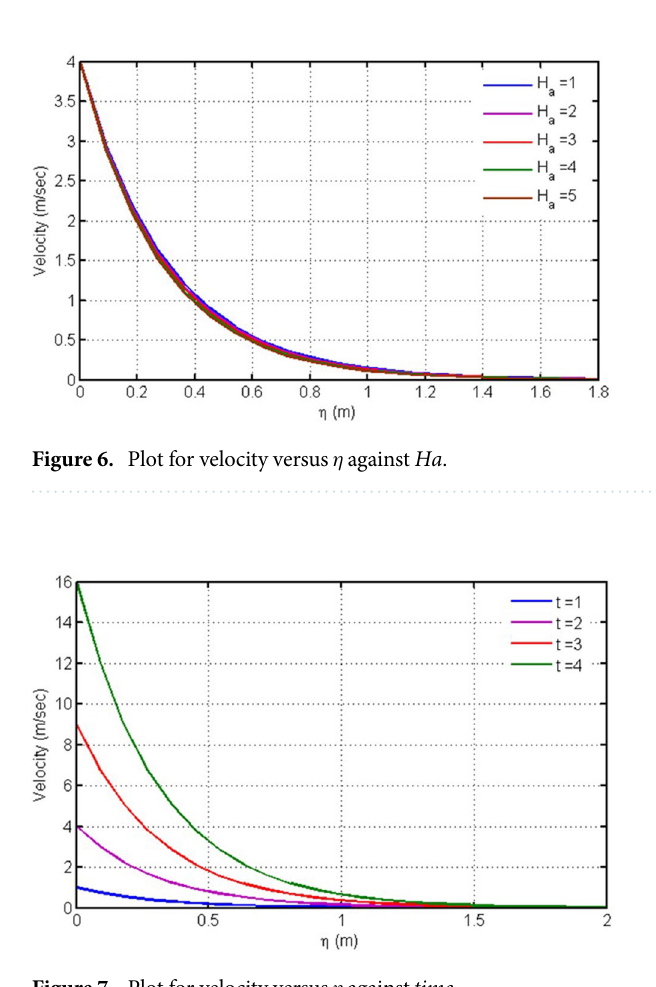
Figure 7. Plot for velocity versus η against time